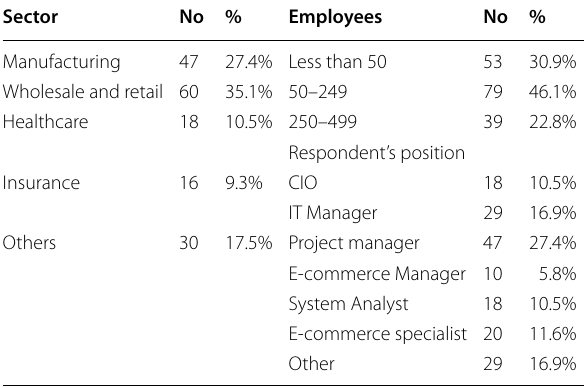
Table 2 Characteristics of the sample